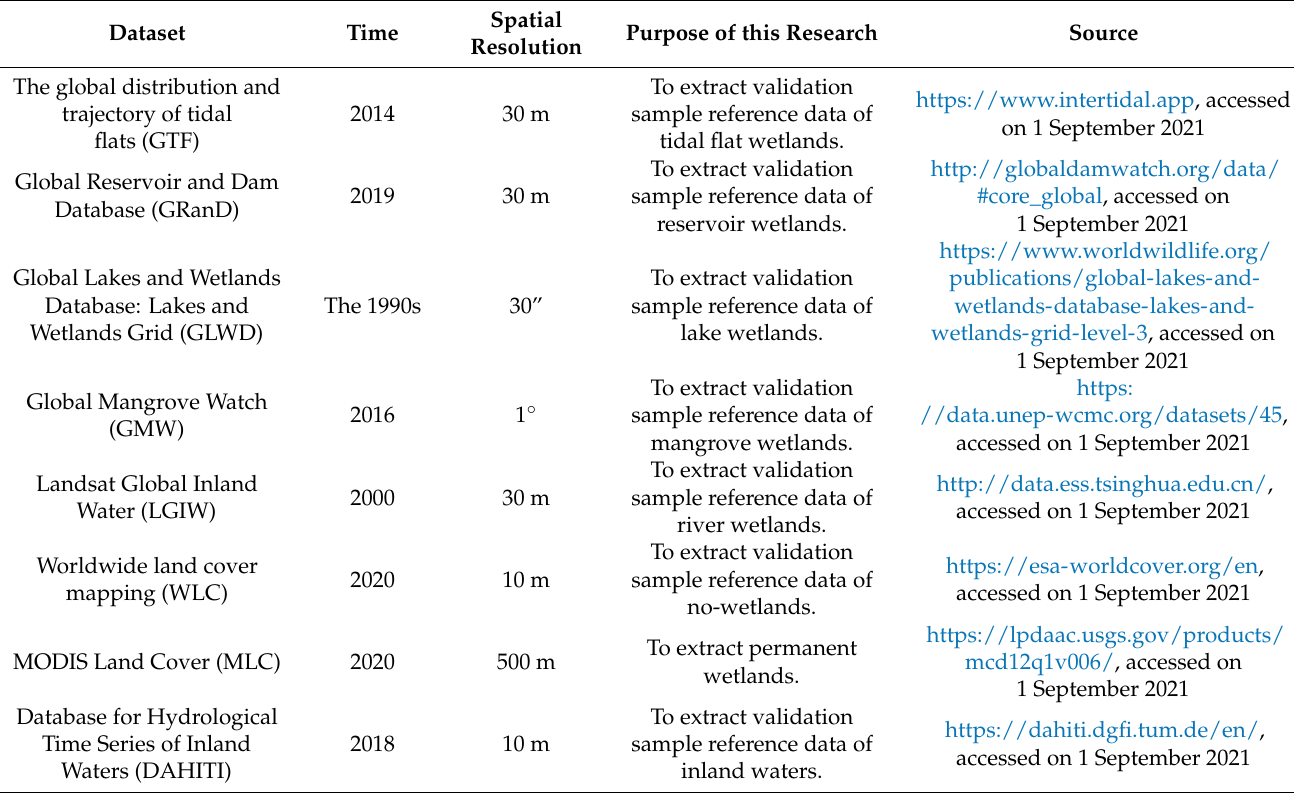
Table 2. The referenced wetland mapping products for collecting